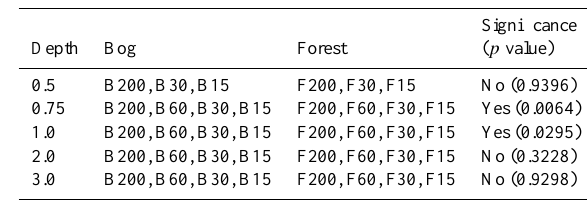
Table 3. Results of a paired t test comparing the hydraulic conduc- tivities of the bog and forest side for each depth.